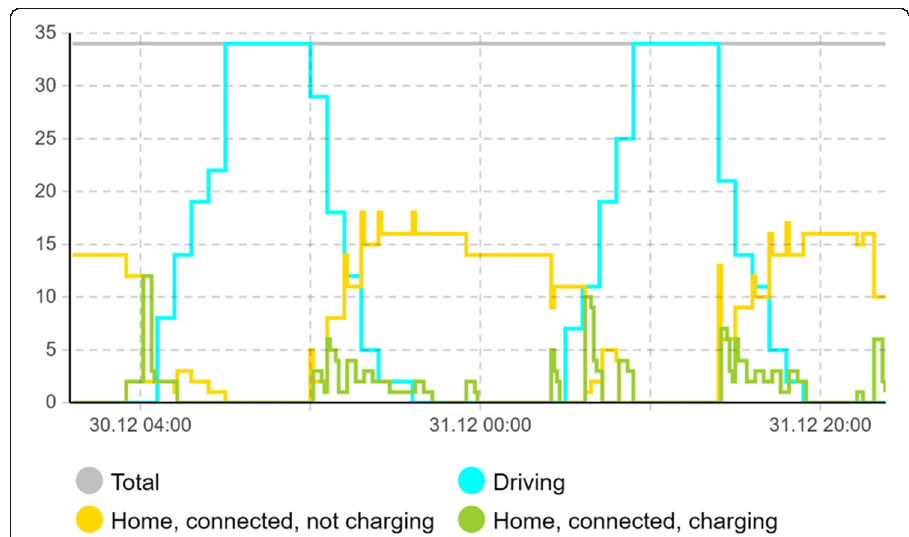
Fig. 15 Simulation model output – number of ElectricVehicle agents in different states. They might either be driving (cyan, Driving state), at home and charging (green, Charging state) or at home but not charging, instead waiting for hours with lower electricity prices (yellow, Connected to Charger state). Electric Vehicles in the Idle state are not